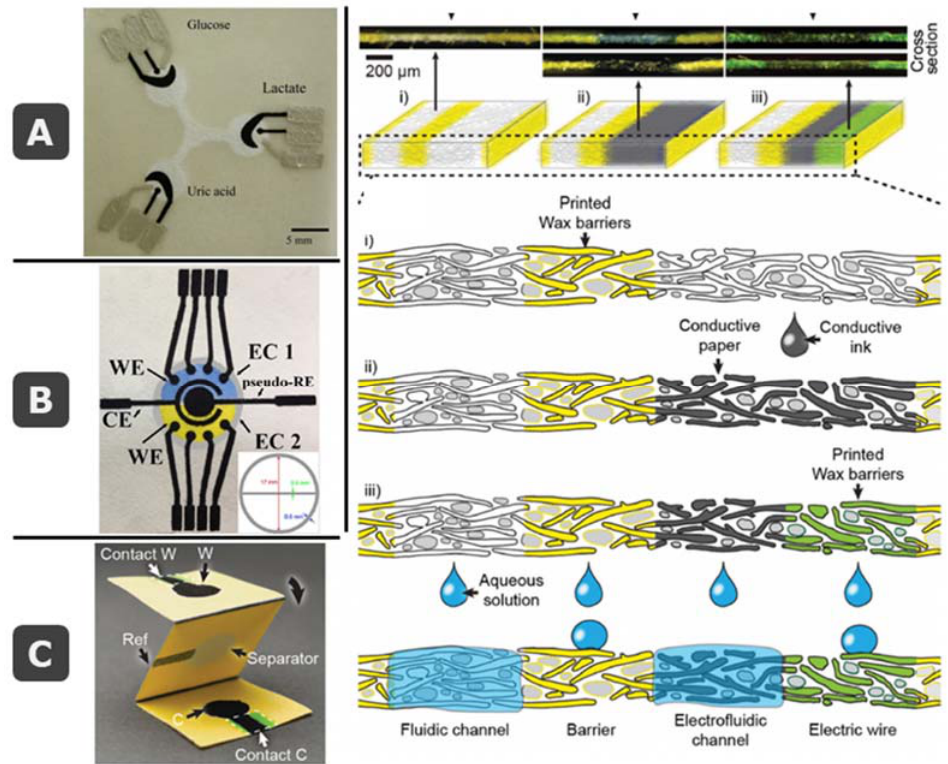
Figure 5. ( A ) Pioneer work on ePADs with screen-printed electrodes (SPEs) for multianalyte enzymatic detection of glucose, uric acid, and lactate. Reprinted with permission from [37]. Copyright (2009) American Chemical Society. ( B ) Picture of the paper-based electrochemical device developed by de Oliveira et al. with two electrochemical cells, with 4 working (WE) each and sharing reference (RE) and counter (CE). Reprinted from [65], Copyright (2019), with permission from Elsevier. ( C ) Integration of microfluidic and electronics, exemplified in an origami-based electroanalytical cell and visual explanation of the concept of electrofluidics. Reprinted with permission from [66], Copyright (2016) Wiley-VCH Verlag GmbH and Co.